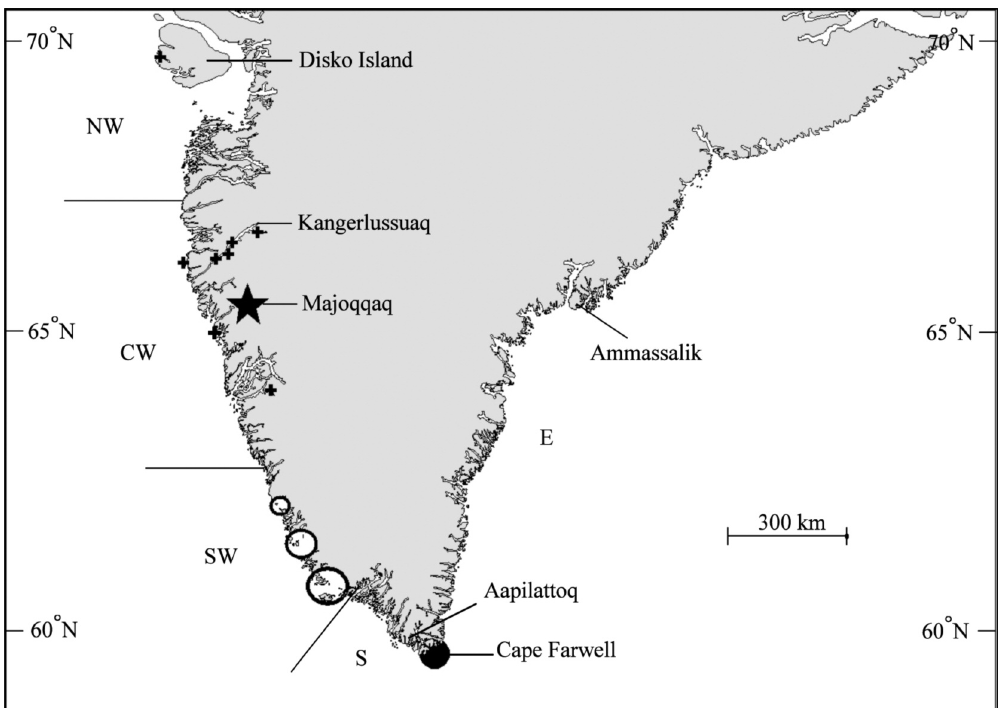
Fig. 1. Map with names of areas mentioned in the text. + marks specific locations and o marks areas where harbour seals were breeding in the early 1960s. These breeding sites are now abandoned or occupied by only a few seals (less than 10 seals observed simultaneously in the recent decade). (cid:2) shows an area in south Greenland where higher numbers of harbour seals (100+) have been seen by hunters within the last 5